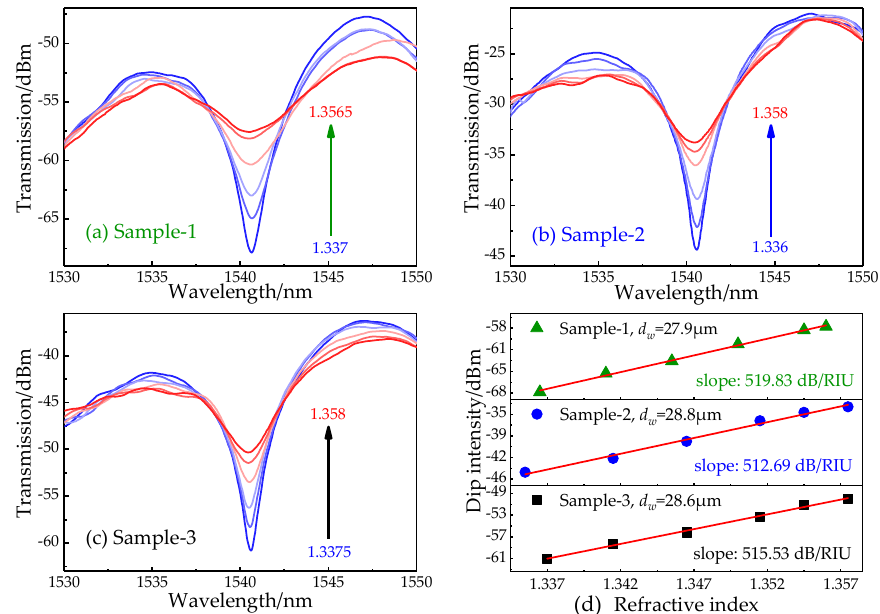
Figure 6. Stability measurements. ( a – c ) The transmission spectra and ( d ) intensity responses with varied SRI of three new SP-based samples.